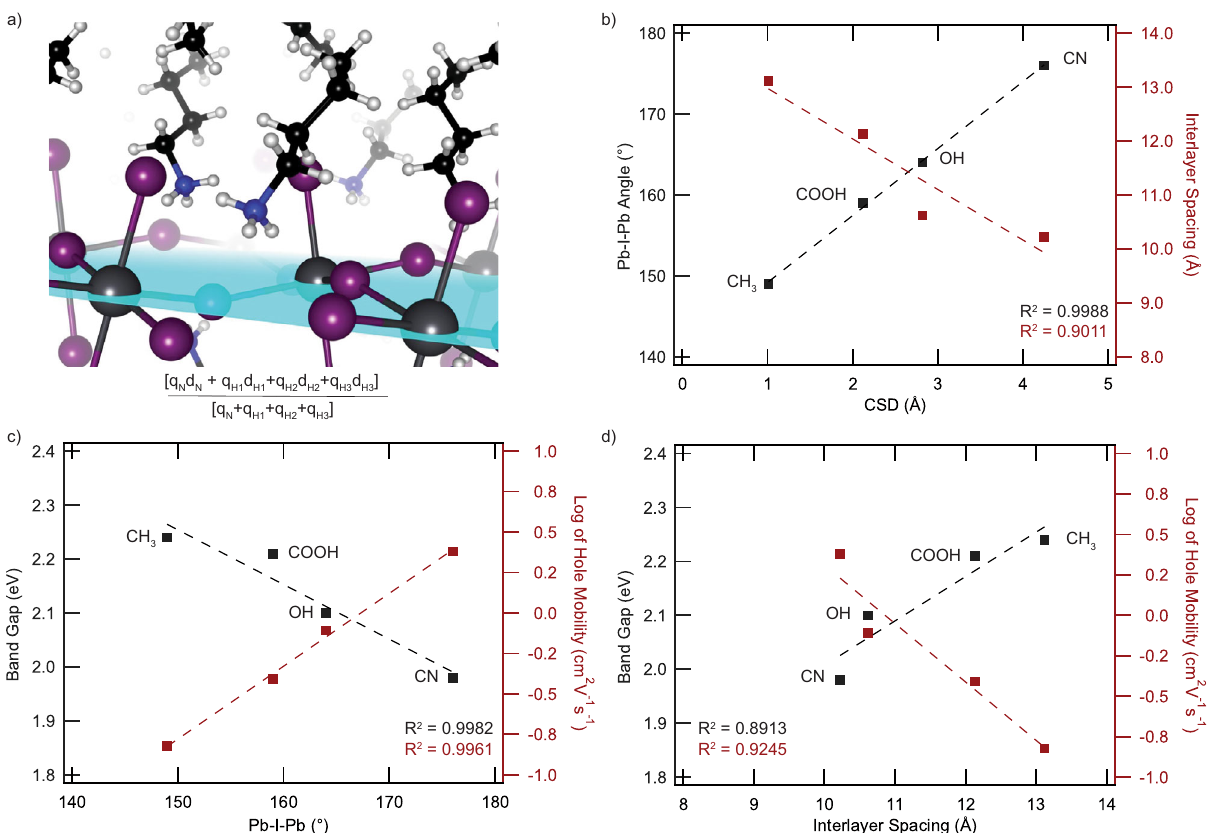
Fig. 3 Charge separation descriptor (CSD) plots to show the relationship between CSD and structural properties and then structural properties to materials properties. a A schematic showing how the CSD value is calculated. index i indicates atoms in the ammonium groups, q i is the Bader charge of an atom, an d d i is its distance to the middle of the inorganic plane; b a close linear correlation is seen between descriptor CSD and both the average Pb-I-Pb angle and the interlayer spacing from experimental structural fi les; c correlation between the Pb-I-Pb angle (from experimental structural fi les) and log of hole mobility and band gap; and d correlation between interlayer spacing and log of hole mobility and band gap. Band gap was determined by UPS to determine the valence band maxima and subtracted this from the E g from absorption of single crystals to determine the valence band minima. The hole mobility was determined by space charge limited current measurements. See the “ Methods ” section for further